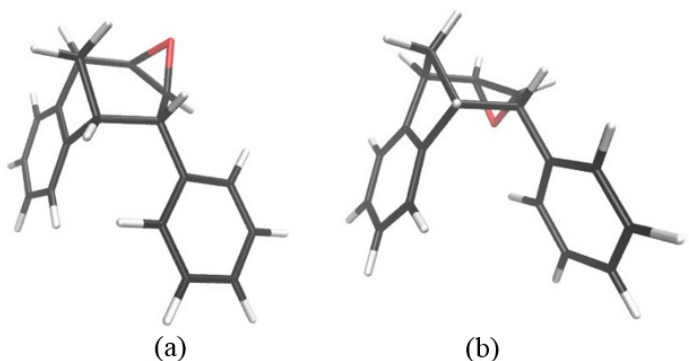
Figure 7. Optimized structures of two stereoisomers of starting epoxide. Isomer ( b ) is thermodynamically more stable than isomer ( a ) by –7.9 kJ mol − 1 .